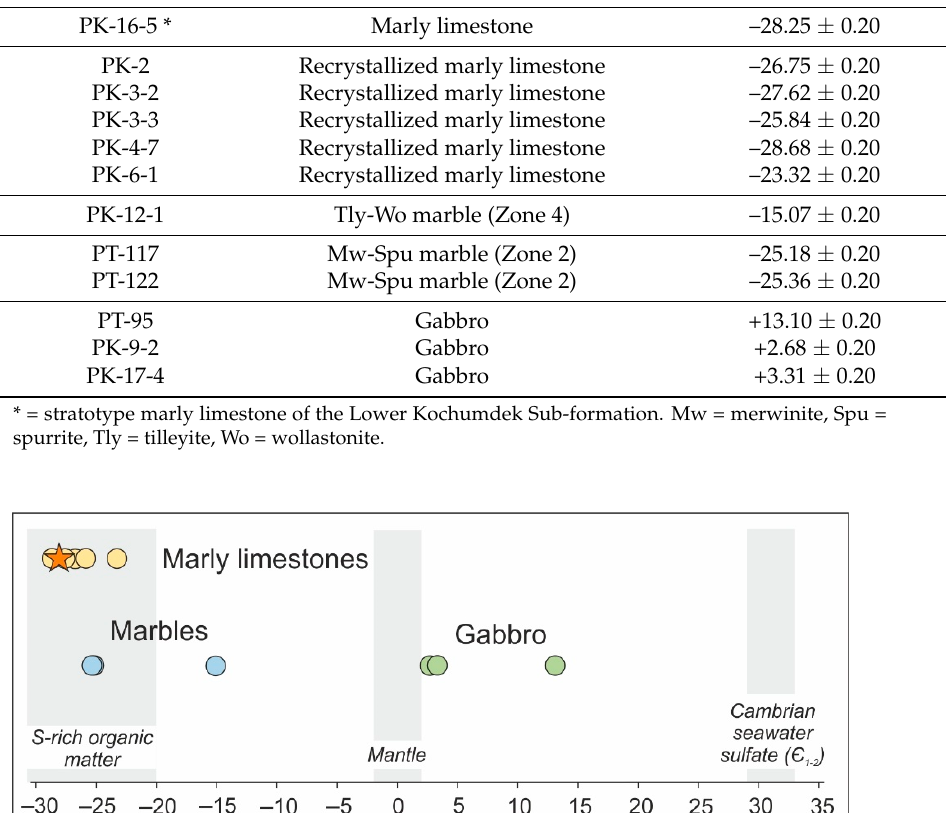
Table 11. Representative analyses of bartonite (K 6 Fe 21 S 27 ) from Tly-Wo marbles (Zone 4) of the Kochumdek contact aureole (SEM-EDS data).